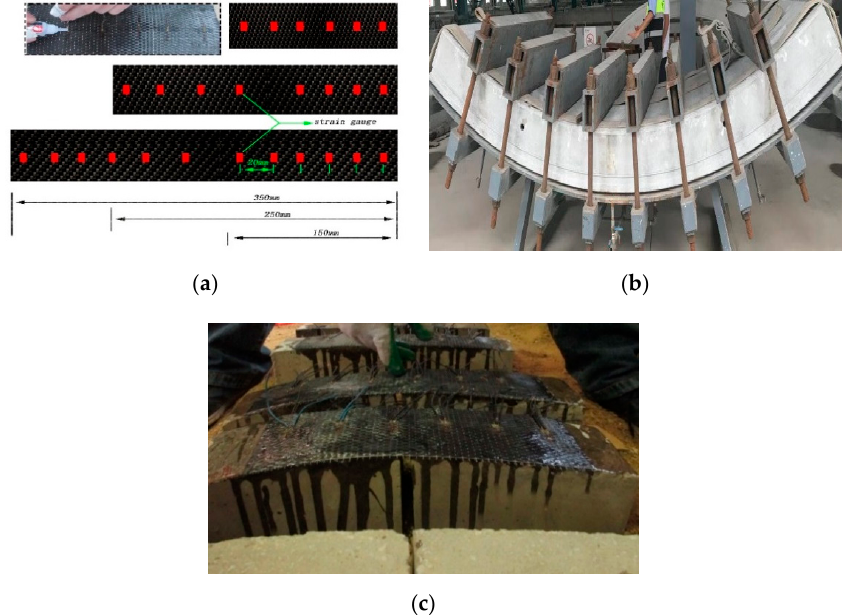
Figure 2. Location of strain gauge paste and rectangular CFRP. ( a ) Resistance strain gauge, ( b ) circular concrete pipe, ( c ) sticking CFRP. Table 2. Slip testing parameters of CFRP-reinforced arch concrete sections.